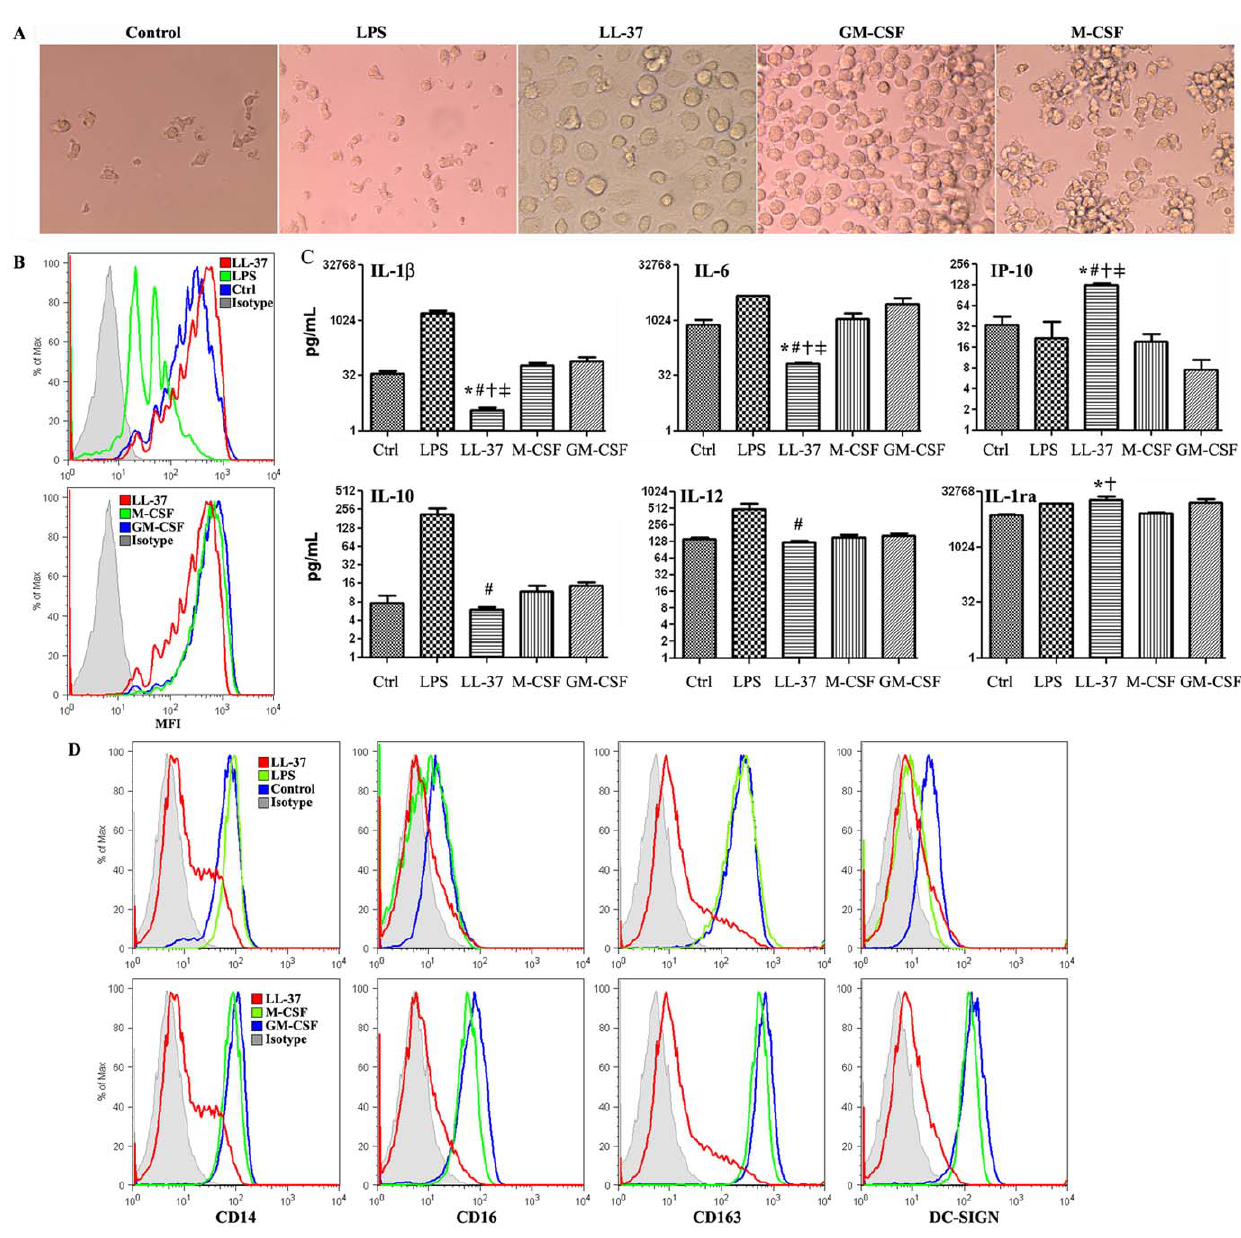
Figure 4. Comparison of monoosteophils with monocyte-derived macrophages. Negatively isolated monocytes at the concentration of 1 6 10 6 /mL were incubated in the presence or absence of 100 ng/mL LPS, 5 m M LL-37, 10 ng/mL GM-CSF, or 50 ng/mL M-CSF for 6 days. A . Cell morphology was shown by phase contrast microscopy (magnification 200 6 ). B . 6-day medium-, LPS-, LL-37-, GM-CSF-, or M-CSF-differentiated monocytes at the concentration of 1 6 10 6 /mL were mixed with fluorescent labeled latex beads at a multiplicity ratio of 1:500, incubated at 37 u C for 1 h, and analyzed by flow cytometry to show phagocytosis (MFI, mean fluorescence intensity). C . After monocytes were incubated with medium, LPS, LL-37, GM-CSF, and M-CSF for 6 days, cytokine/chemokine levels in cultured supernatant were analyzed (pg/mL, mean 6 SE). D . 6-day medium-, LPS-, LL-37-, GM-CSF-, or M-CSF-differentiated monocytes were harvested, stained with antibodies, and analyzed by flow cytometry. Data shown were from three or four independent experiments.